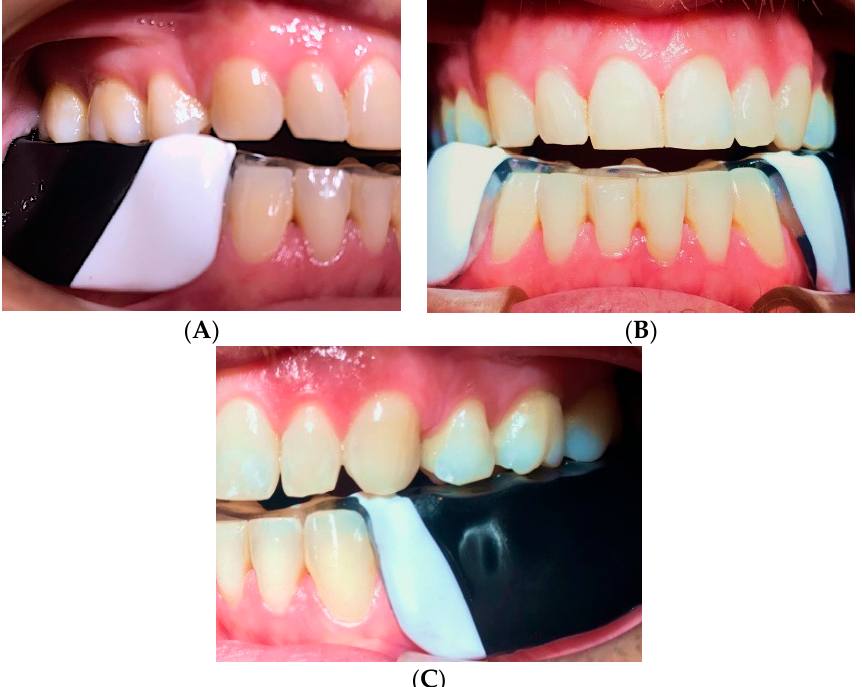
Figure 10. ( A ) right side view of OSSPD in mouth; ( B ) anterior view of the OSSPD in the mouth; ( C ) left lateral view of OSSPD in the